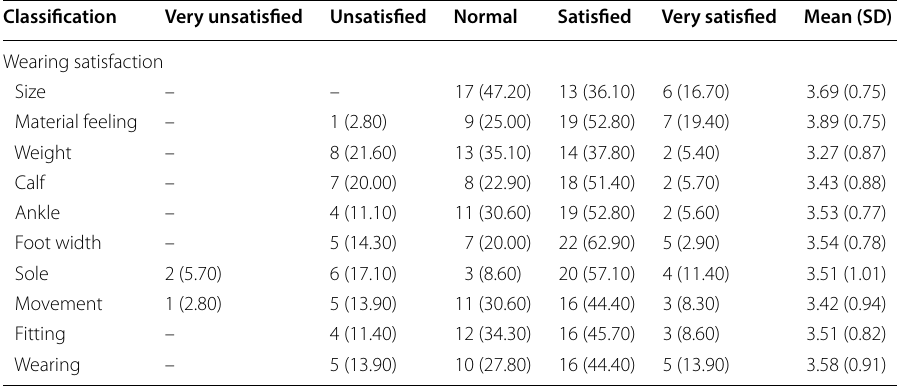
Table 6 Wearing satisfaction of improved design prototype (N/%)